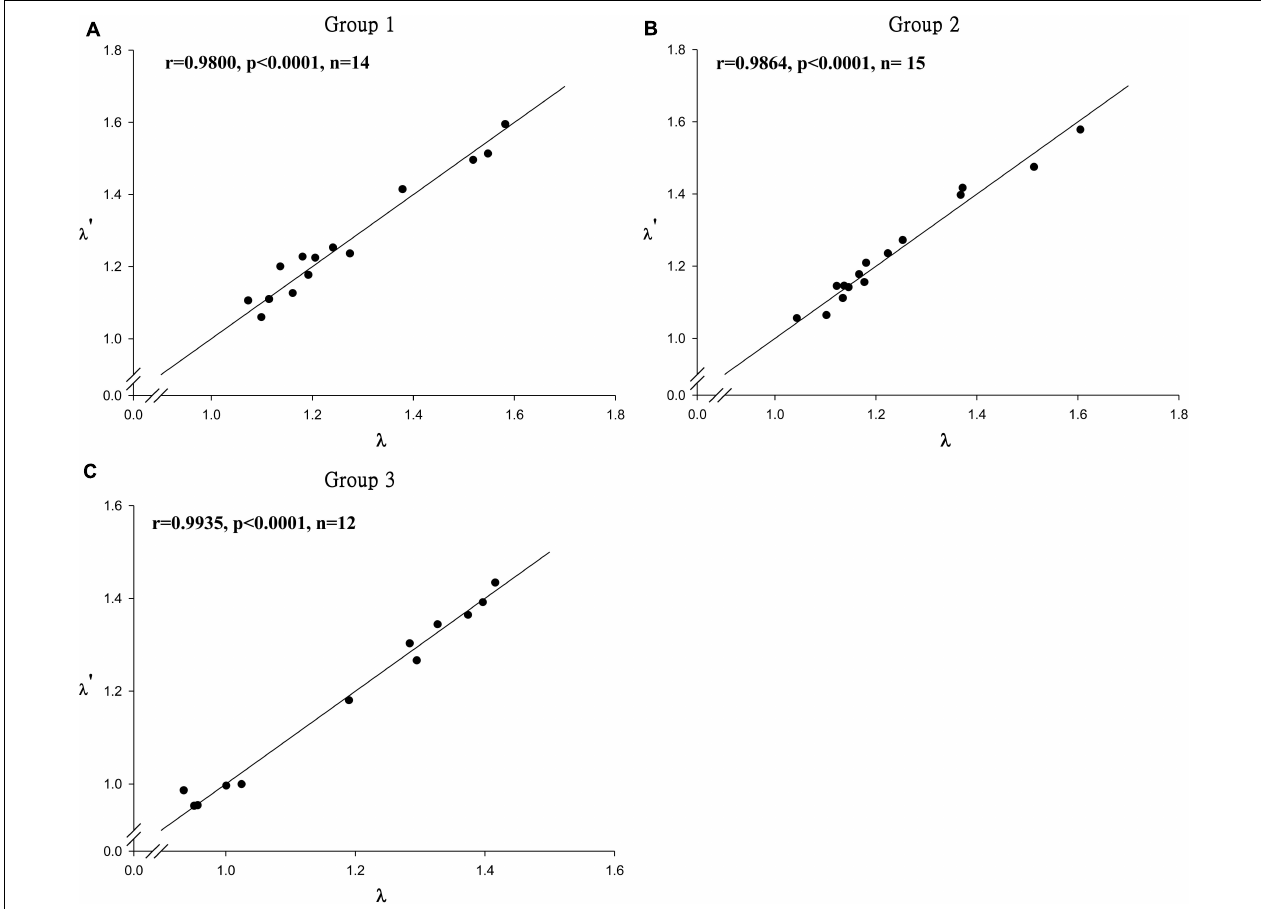
FIGURE 4 | The relation between λ and λ (cid:48) for 41 stocks. Where λ (cid:48) represent the population growth rate estimated from the empirical equation developed in this study and λ represent the population growth rate estimated from conventional demographic approach for groups 1, 2, and 3 [ (A–C) respectively].